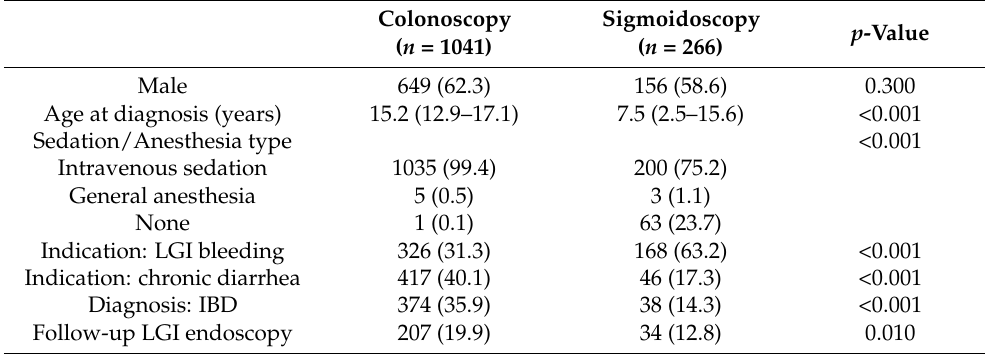
Table 5. Comparison of characteristics between patients receiving colonoscopies and sigmoido-